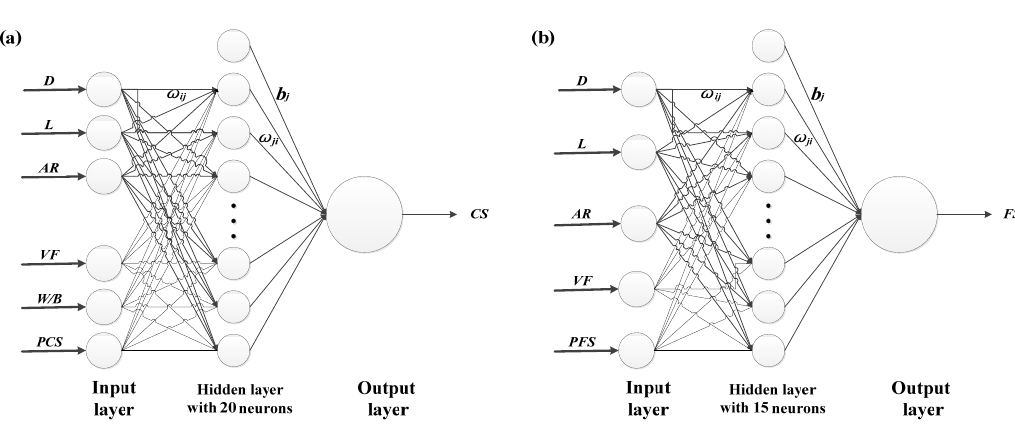
Figure 2. Structure of ANN models, ( a ) Compressive strength ANN model, ( b ) Flexural strength ANN model; W/B (water to binder ratio); PCS (compressive strength of UHPFRC without fibers); VF (volume fractions); AR (aspect ratio); PFS (flexural strength of UHPFRC without fibers); CS (compressive strength of UHPFRC); FS (flexural strength of UHPFRC). In ( a ), the compressive strength ANN model developed in this study has three layers with six neurons in input layer, twenty neurons in hidden layer and one neural in output layer; in ( b ), the compressive strength ANN model that was developed in this study has three layers with five neurons in input layer, fifteen neurons in hidden layer, and one neural in output layer. In these two figures, ω ij is the weight between the i th neuron in the input layer and the j th neuron in the hidden layer, ω ji is the weight between the i th neuron in the hidden layer and the j th neuron in the output layer, and b j is the bias of the j th layer in the output layer; Table 4. Parameters used in the ANN models.